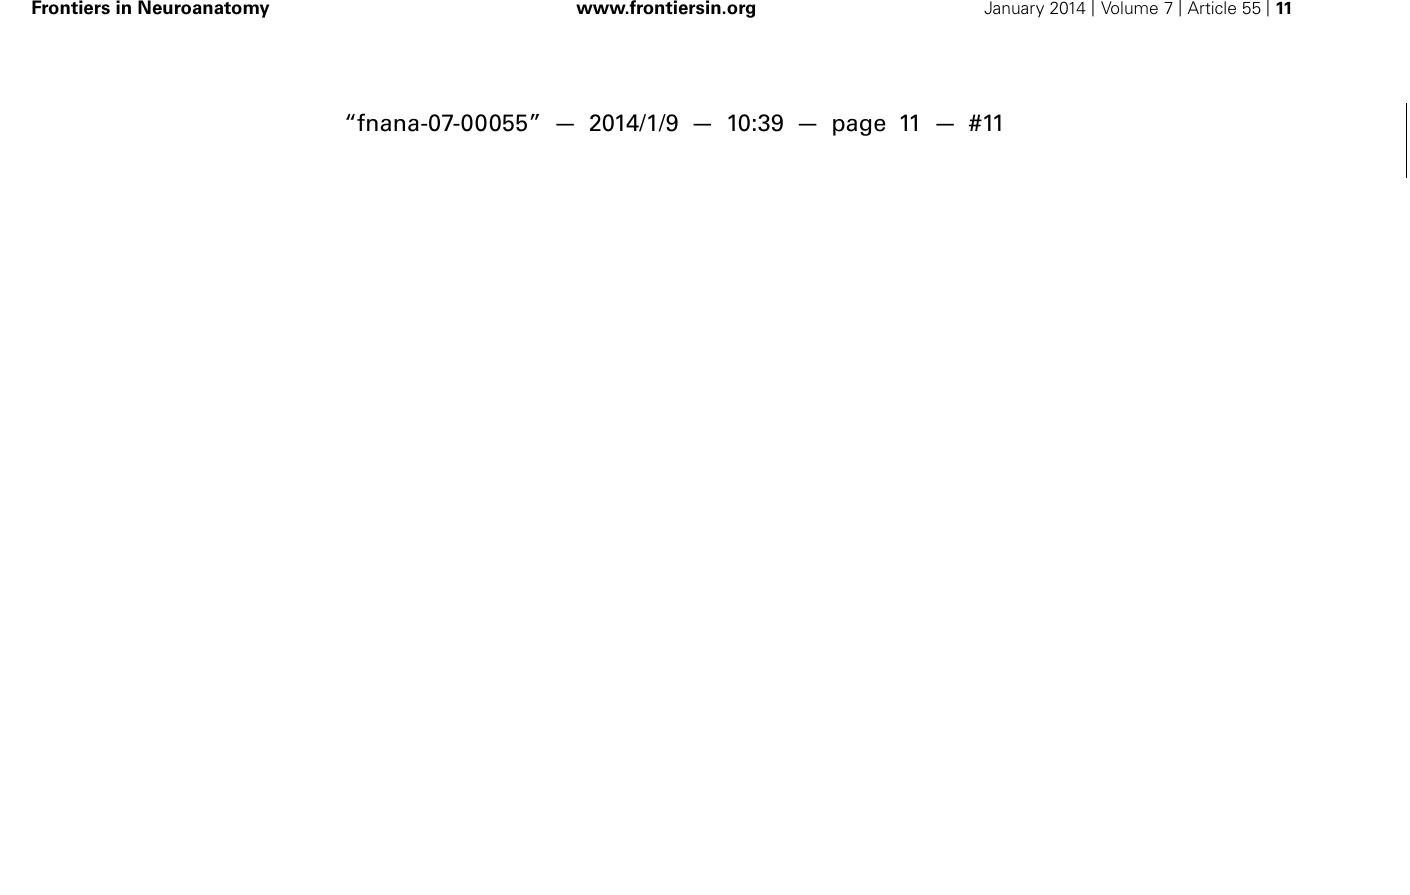
produced labeled cells almost entirely within the ipsilateral